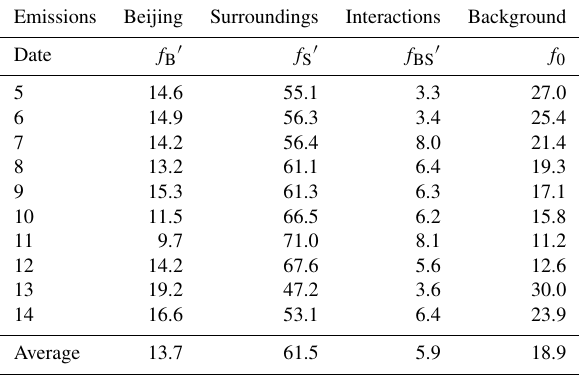
Table 3. Average O 3 contributions (%) from 12:00 to 18:00BJT in Beijing from local and non-Beijing emissions, as well as the back- ground emissions and interactions of both emissions from 5 to 14 July 2015.